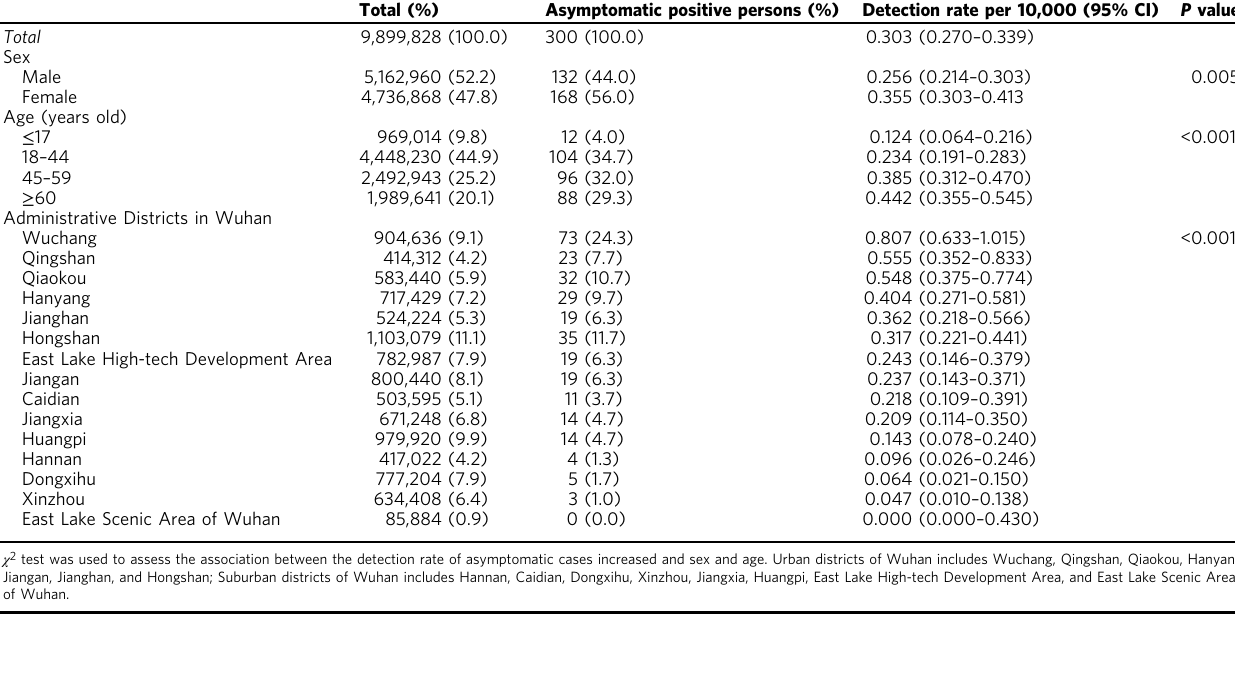
Table 1 Characteristics of asymptomatic positive individuals.